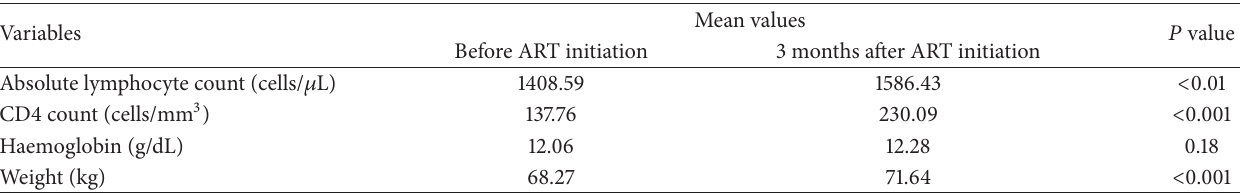
Table 3: Comparison of laboratory markers and weight in HIV-infected individuals before and 3 months after initiation of antiretroviral therapy